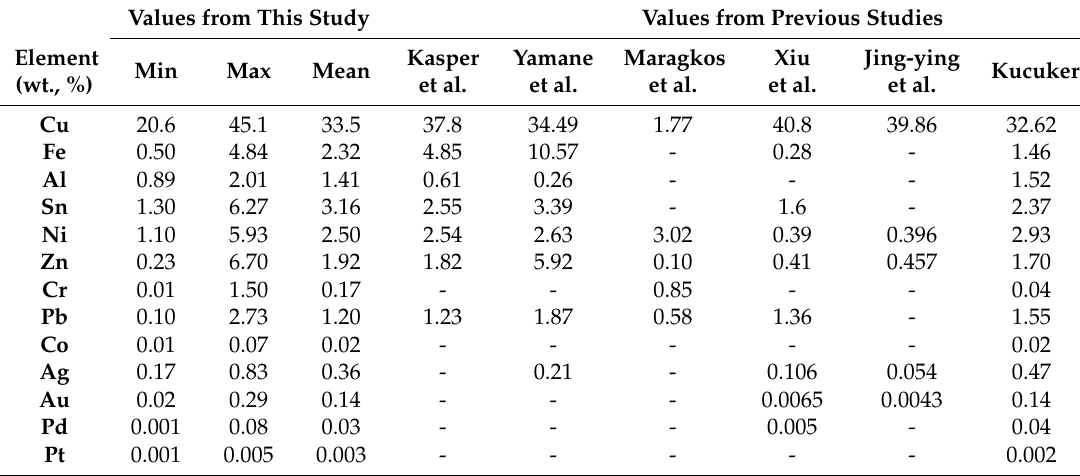
Table 7. Metal concentration values (wt. %) in PCBs of mobile phones [3,31,43,44,48]. Values from This Study Values from Previous Studies